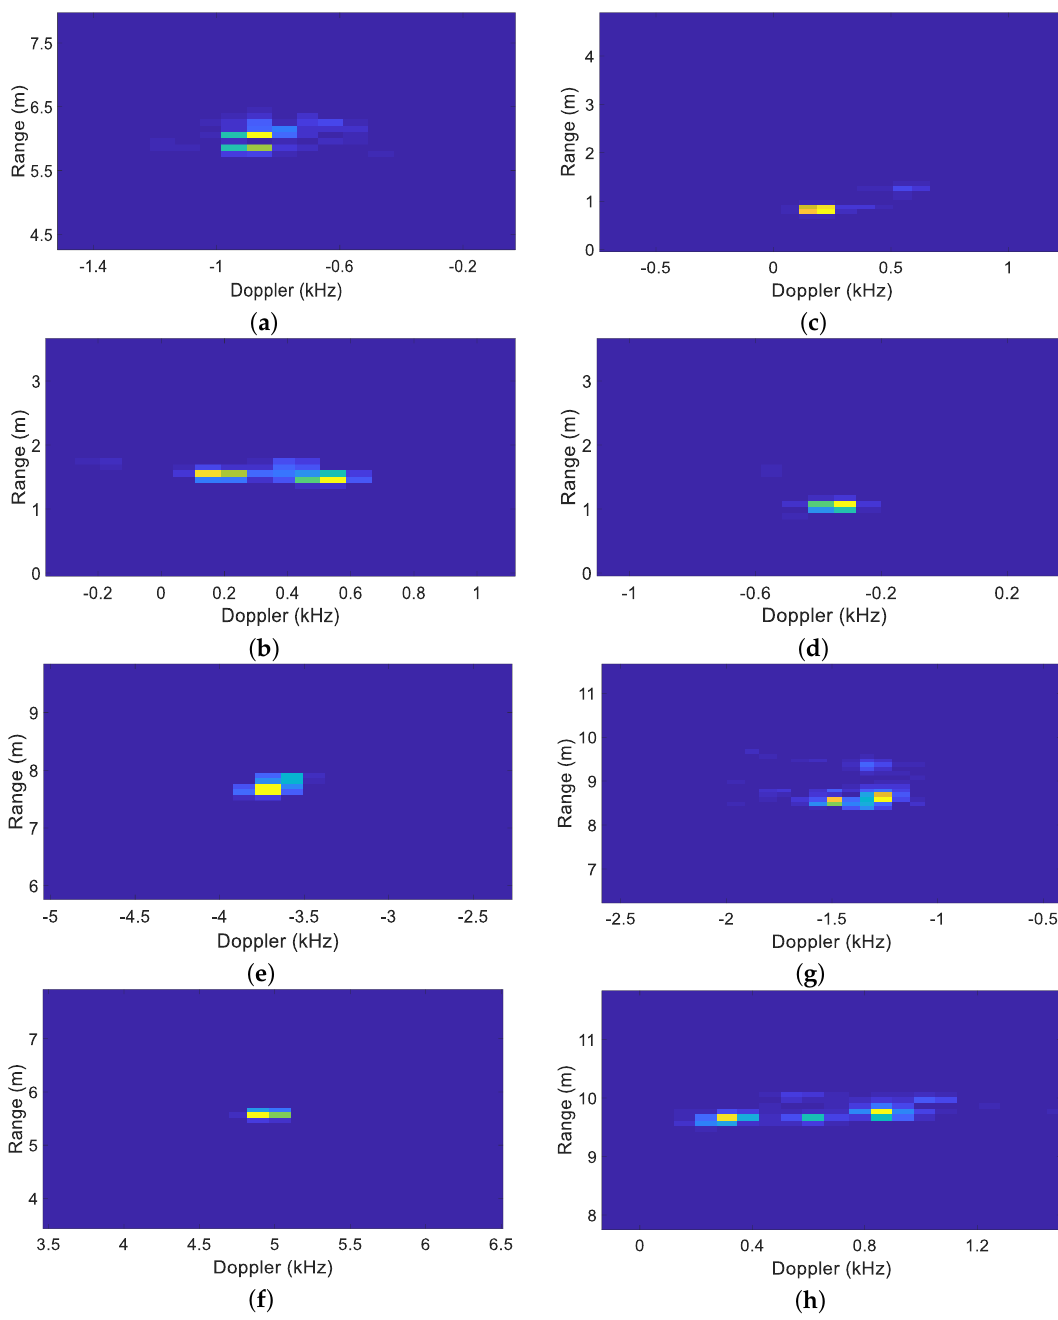
Figure 4. Range -Doppler images of pedestrian and vehicle. ( a ) pedestrian longitudinal movement (forwards); ( b ) pedestrian longitudinal movement (towards); ( c ) pedestrian lateral movement (left to right); ( d ) pedestrian lateral movement (right to left); ( e ) vehicle longitudinal movement (forwards); ( f ) vehicle longitudinal movement (towards); ( g ) vehicle lateral movement (left to right); ( h ) vehicle lateral movement (right to